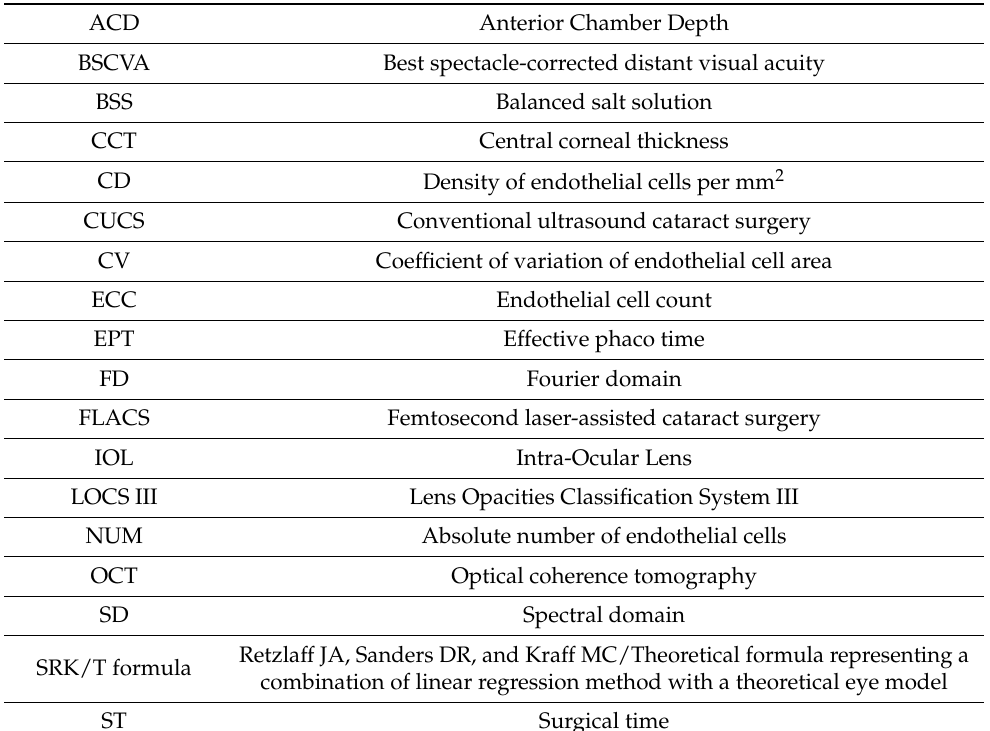
Table 1. Terms and abbreviations mentioned more than once in the